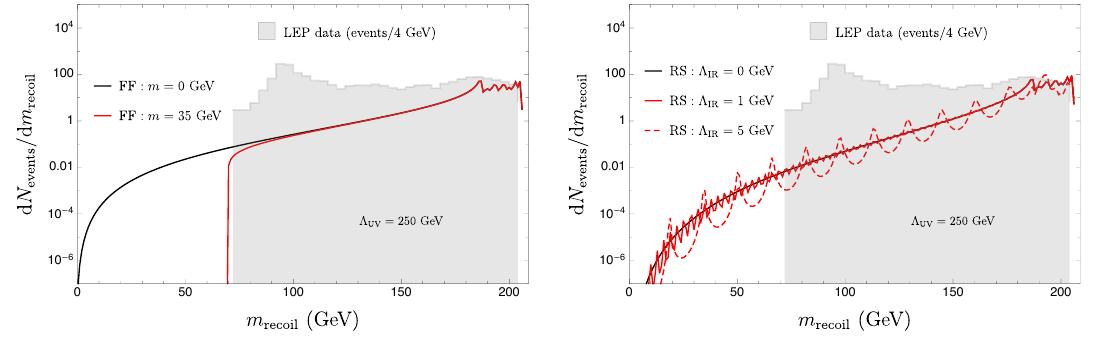
Figure 4 . Differential number of events for e + e − → DS + γ as a function of the recoil mass (equal to the DS invariant mass) at LEP. The black and red curves in the left panel correspond to the prediction of the second model of section 2.3, which leads to a DS with one Majorana fermion coupled to the SM through the D = 6 portal of eq. (2.9). We have set κ = 1 , Λ = m = 250 GeV, J UV φ and the fermion mass m = m to the value indicated in the plot. Similarly, the curves in the right χ panel show the prediction of the RS model of section 2.4, where the DS couples through the D = 8 portal of eq. (2.13). We have set ( N 2 − 1) = 10 (corresponding to c T = 400 , see eq. (B.8)), CFT κ T = 1 and Λ UV = 250 GeV. The gray region shows the number of events measured at LEP by the L3 Collaboration